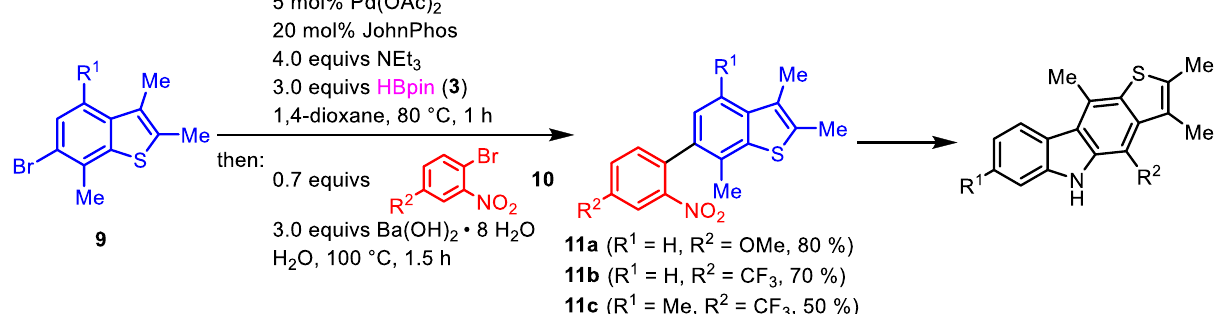
Figure 9. Queiroz’ one -pot MBSC synthesis of 2-methyl- 2‘ -nitro biaryls 11 [36].